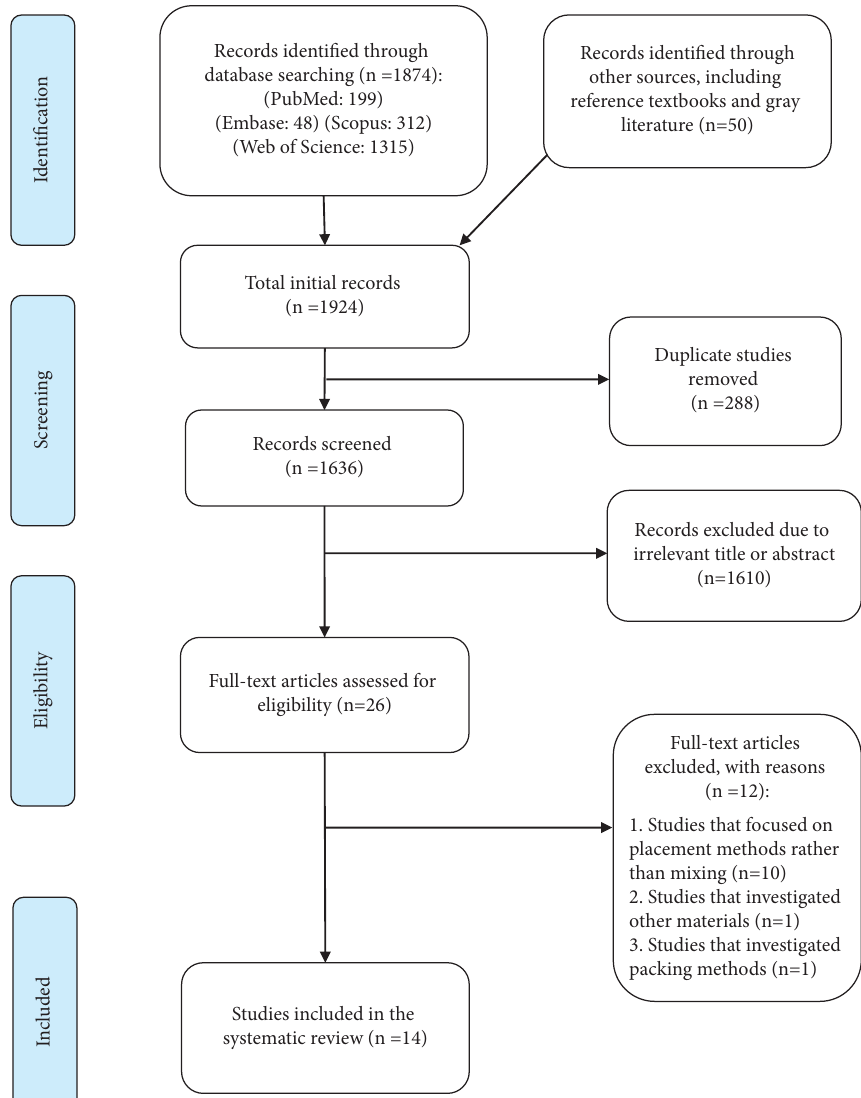
Figure 1: Flow diagram of screening process based on PRISMA